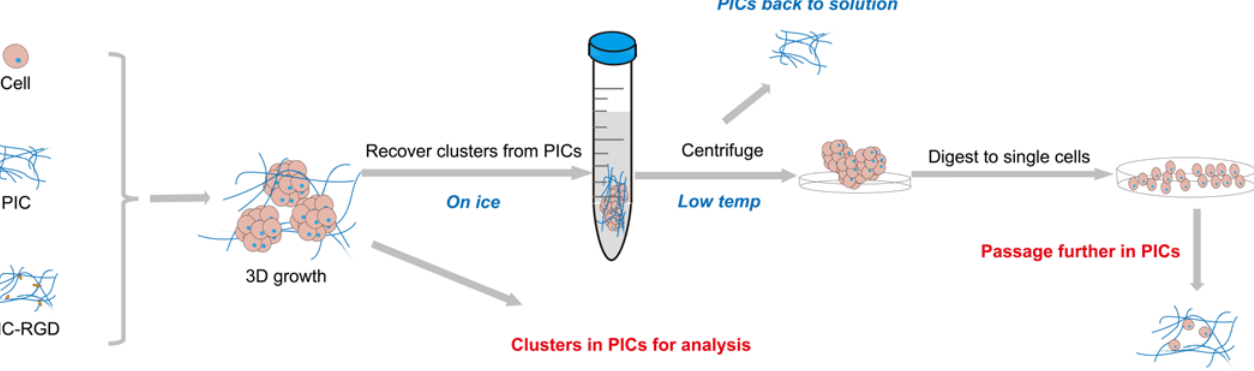
Figure 6. Schematic overview of the 3D culture process based on PIC hydrogels.